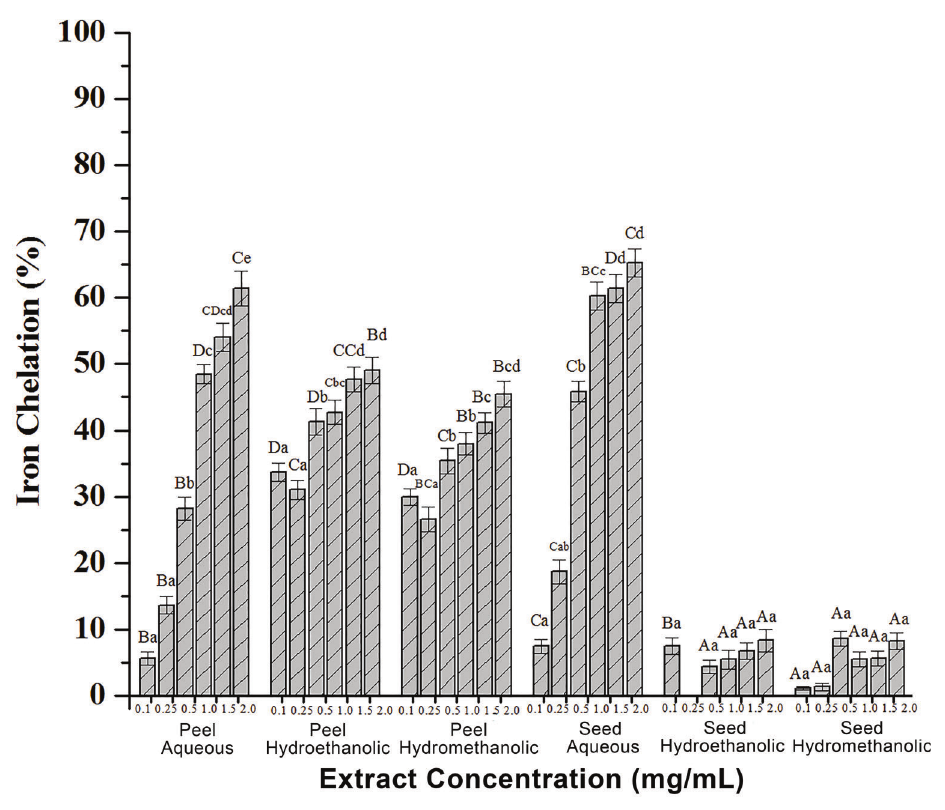
Figure 3. Antioxidant activity of melon peel and seed extracts by iron chelating effect. Different lower-case letters indicate a signi fi cant difference between melon residues extracts when compared at each concentration. Different upper-case letters indicate a signi fi cant difference between melon residues extracts at the same concentration (P o 0.05, ANOVA). Data are reported as means ± SD of 3